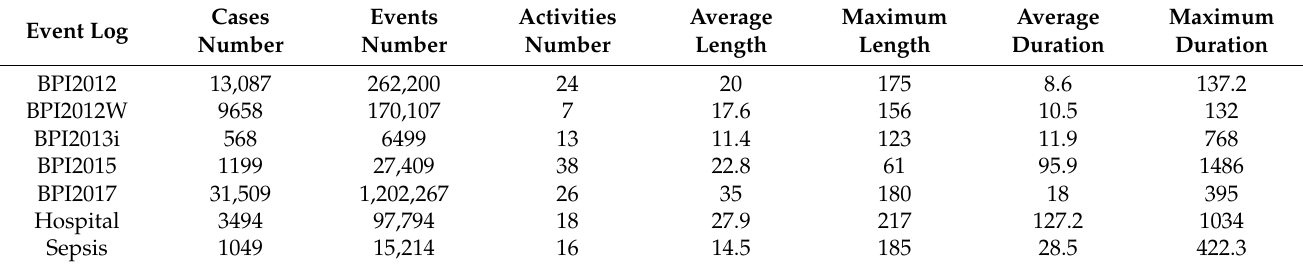
Table 1. Descriptive statistics of event logs. Duration related measures are shown in